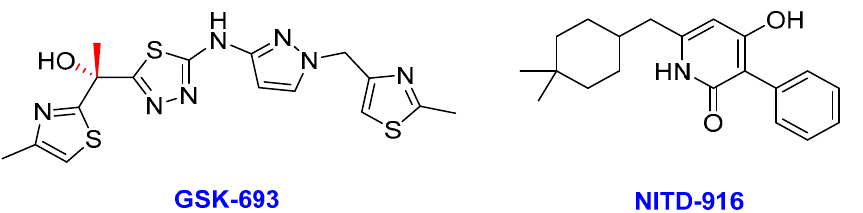
Figure 11. The chemical structures of GSK-693 and NITD-916; novel direct Mtb InhA inhibitors.